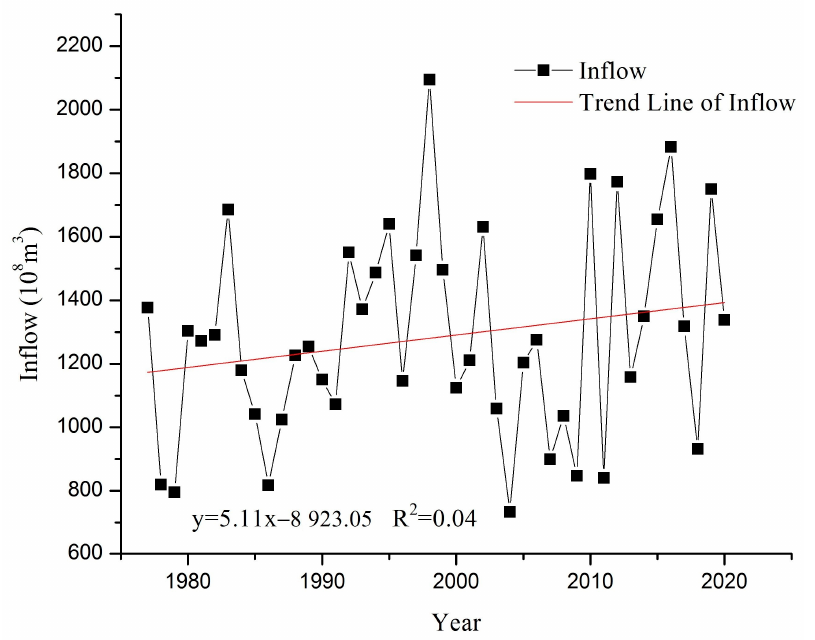
Figure 5. Characteristics of inflow in Poyang Lake during 1977–2020.